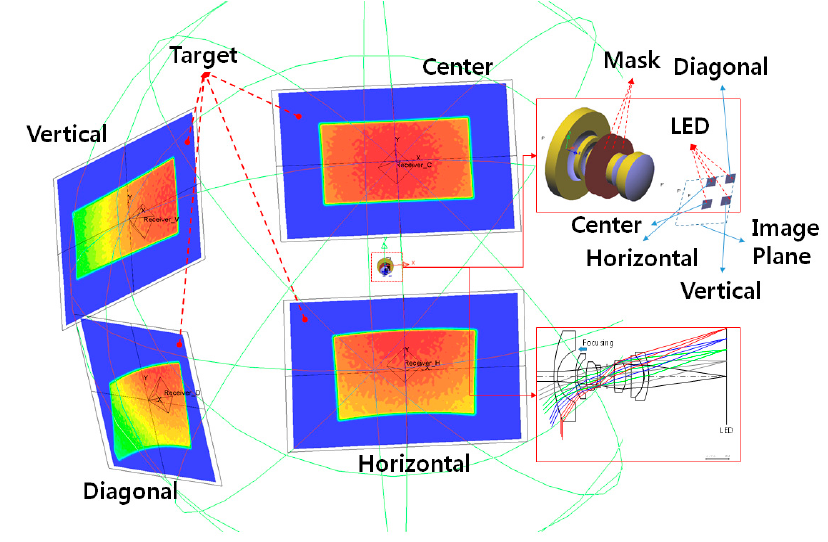
Figure 5. Fisheye lens illumination setup.